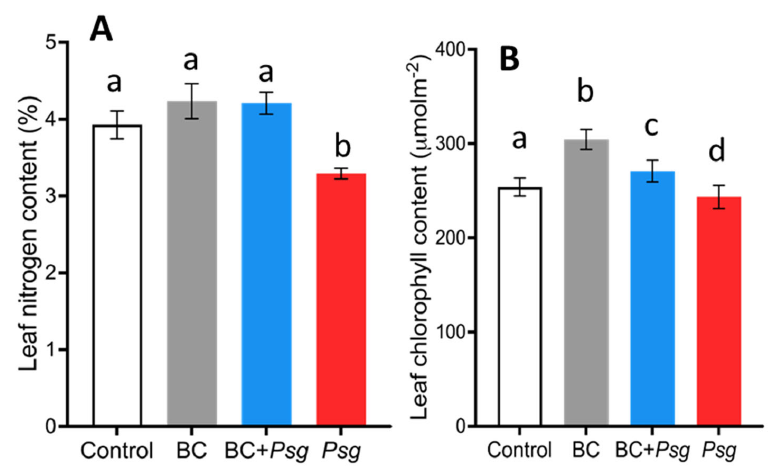
Figure 4. ( A , B ) . Variations in mean leaf nitrogen content ( A ) and chlorophyll concentration ( B )